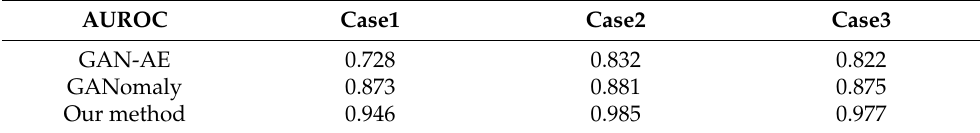
Table 7. AUROC metrics for three methods under three input conditions.